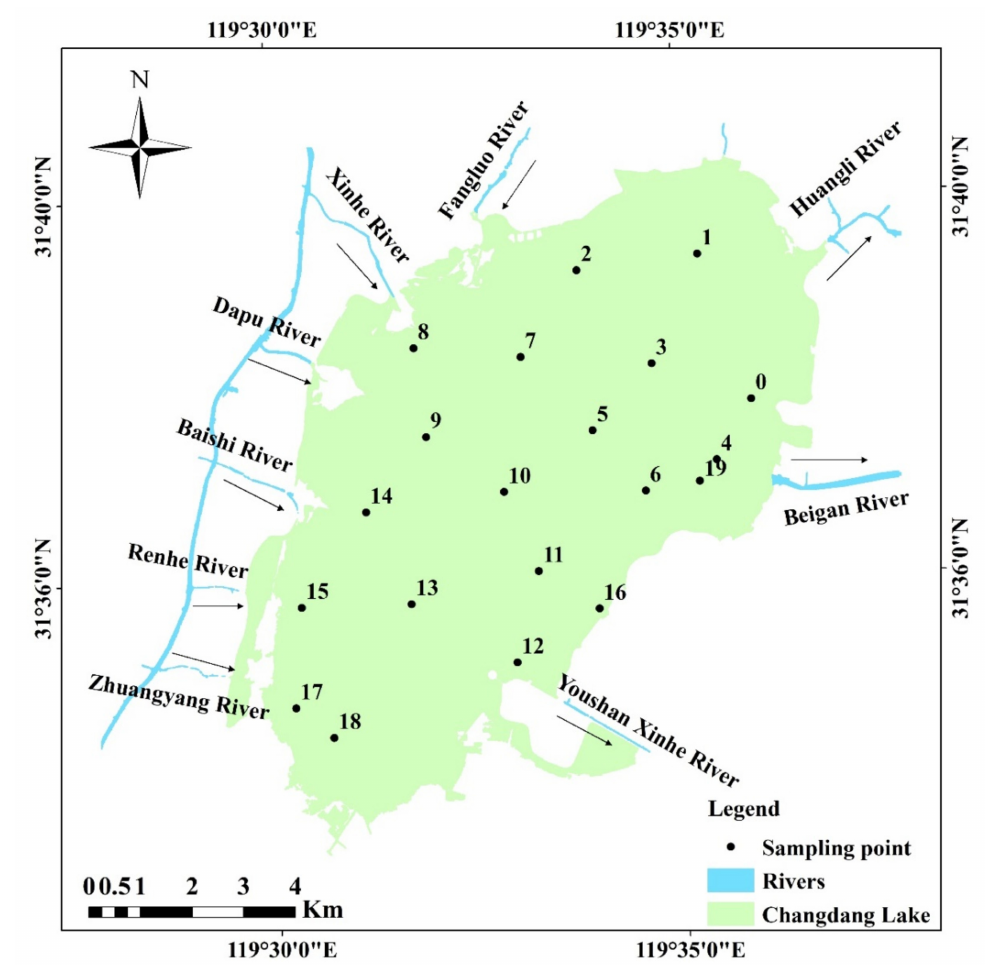
Figure 1. Location of the study area and sampling